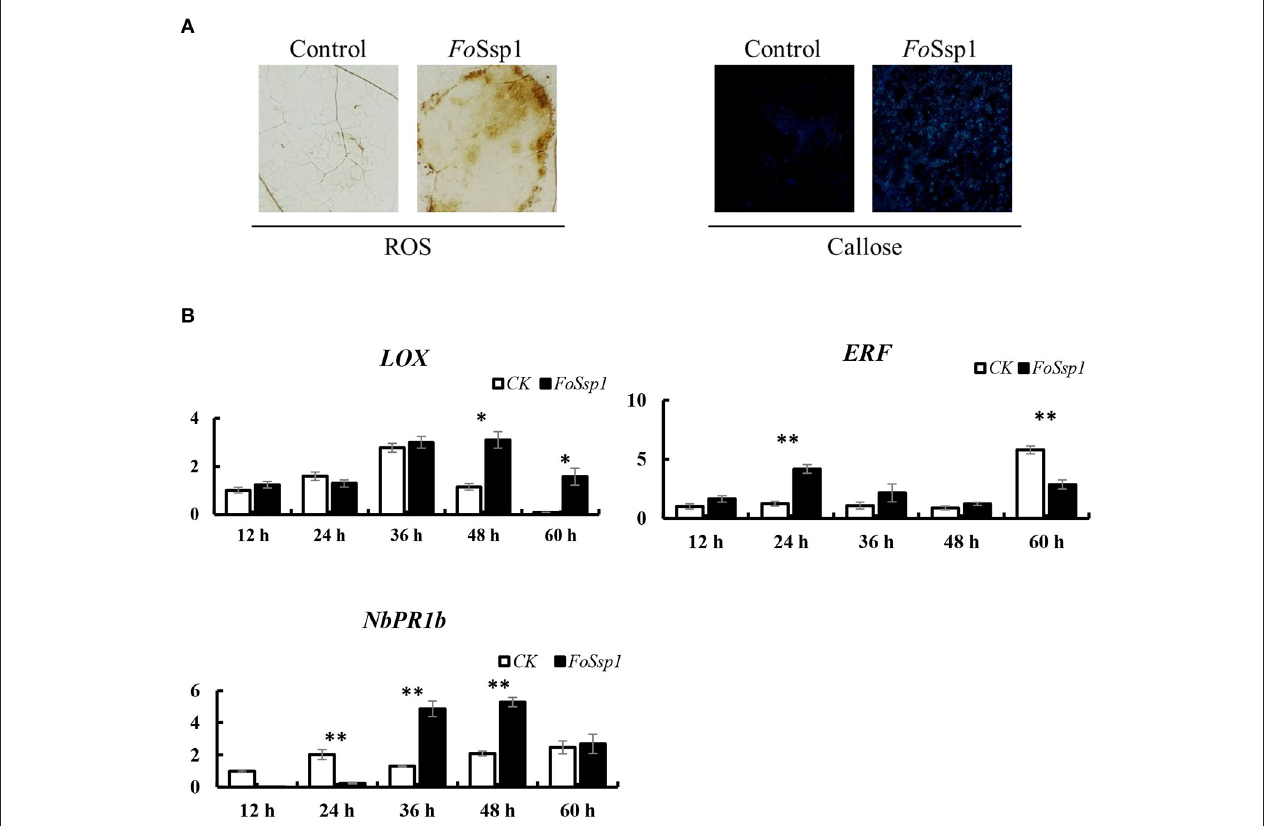
FIGURE 8 | FoSsp1 can induce basic immune response in plants. (A) Tobacco leaves were infiltrated by A. tumefaciens -mediated transformation and stained with DAB and aniline blue 2 days post infiltration. Oxygen accumulation and callose depositions were visualized in tobacco leaves. The representative images were captured at 48 hpi. (B) The expression levels of 3 genes related to immune response were analyzed by qRT-PCR. The pBin-eGFP was the control group, and actin in tobacco was the internal reference gene. The expression of CK and FoSsp1 at the same time point were compared using one-way ANOVA. Asterisks represent significant differences in one-way ANOVA ( p < 0.01). The results are representative of three independent